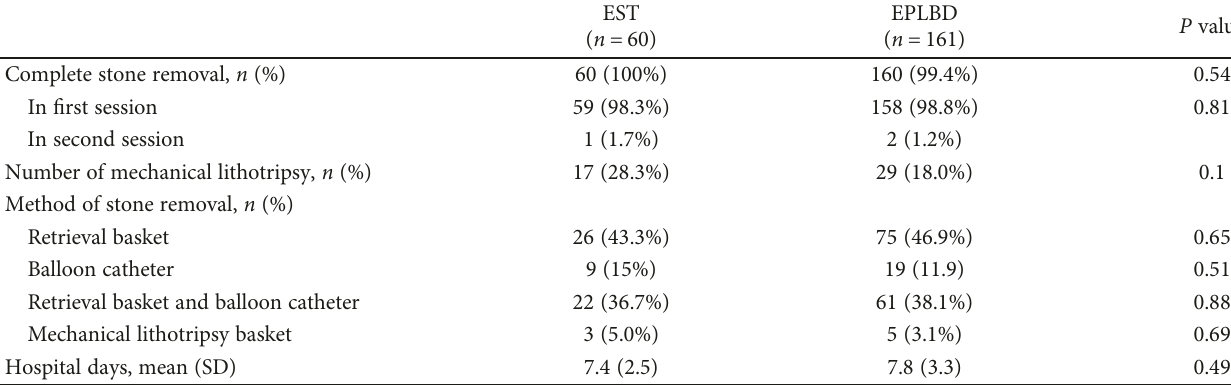
Table 2: Comparison of procedural details between the EPLBD group and the EST group.